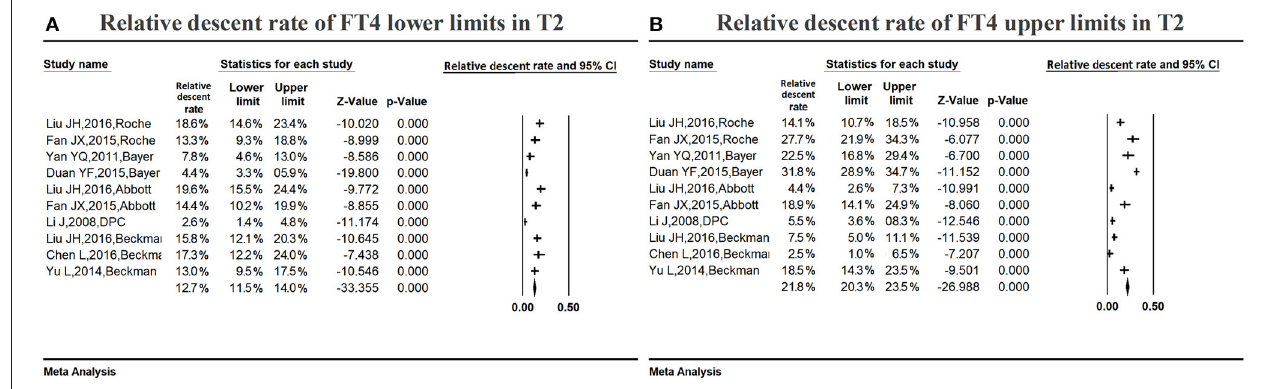
FIGURE 7 | Meta-analysis of relative descent rate of FT4 lower (A) and upper (B) reference limits in middle pregnancy. Figure shows unadjusted relative descent rate of FT4 lower (A) and upper (B) limit estimates in middle pregnancy with 95% confidence limits for each study selected. Pooled relative descent rate estimates are represented as diamonds in this plot.